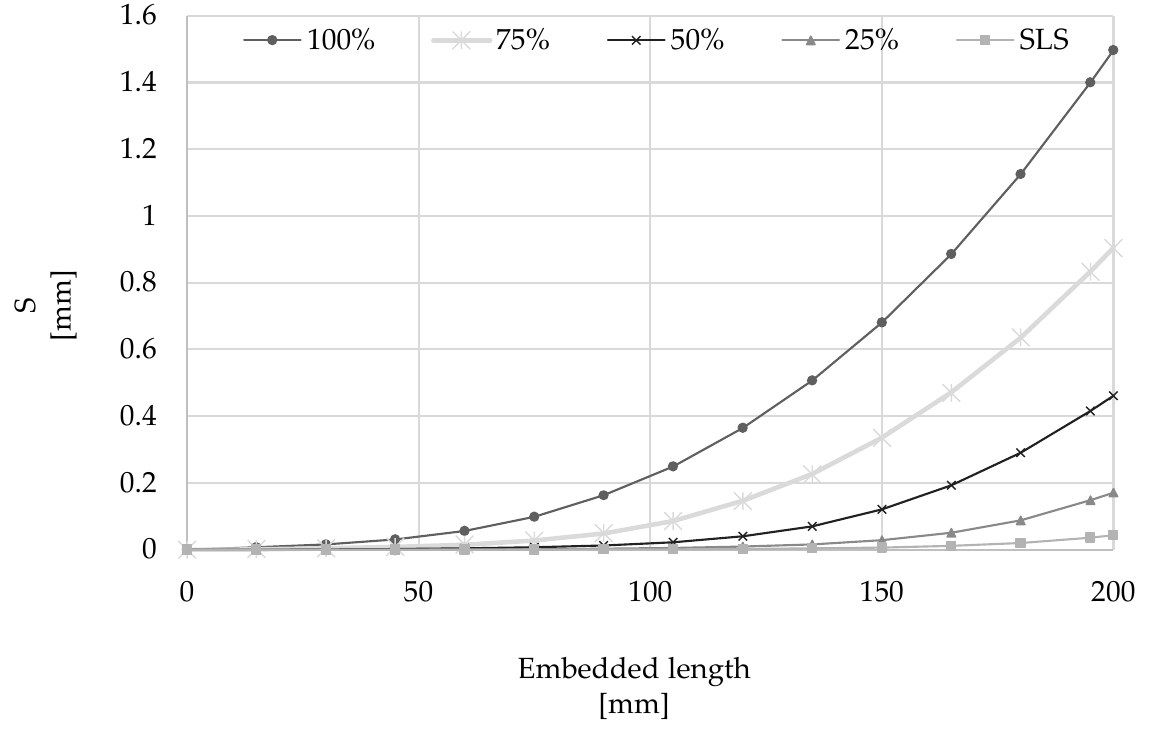
Figure 14. Distribution of slip along the embedded length of 200 mm at several load levels.